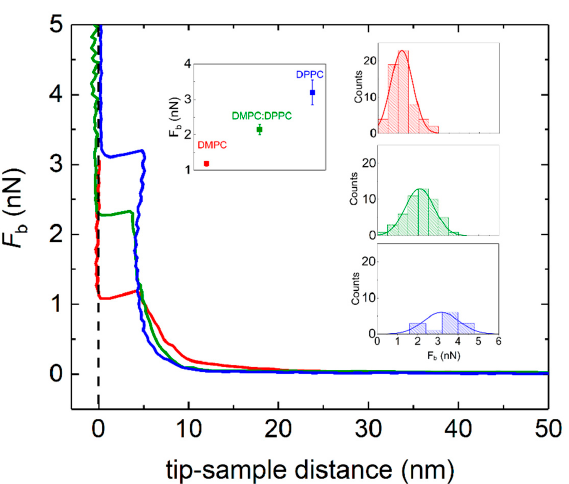
Figure 8. Approach force-distance curves on DMPC (red solid line), DMPC:DPPC (green solid line), and DPPC (blue solid line) supported lipid bilayers on Au-coated QCM-D sensors. Inset: Corresponding histograms taken from a given number of force-distance curves.